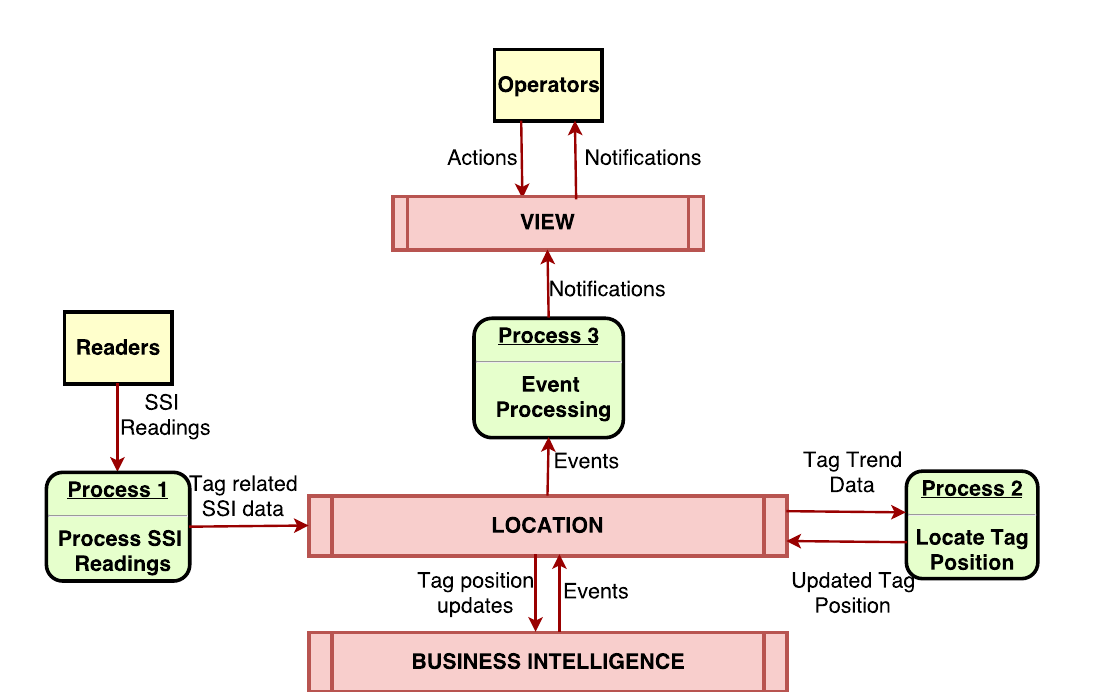
Figure 7. Communications in the indoor positioning fog